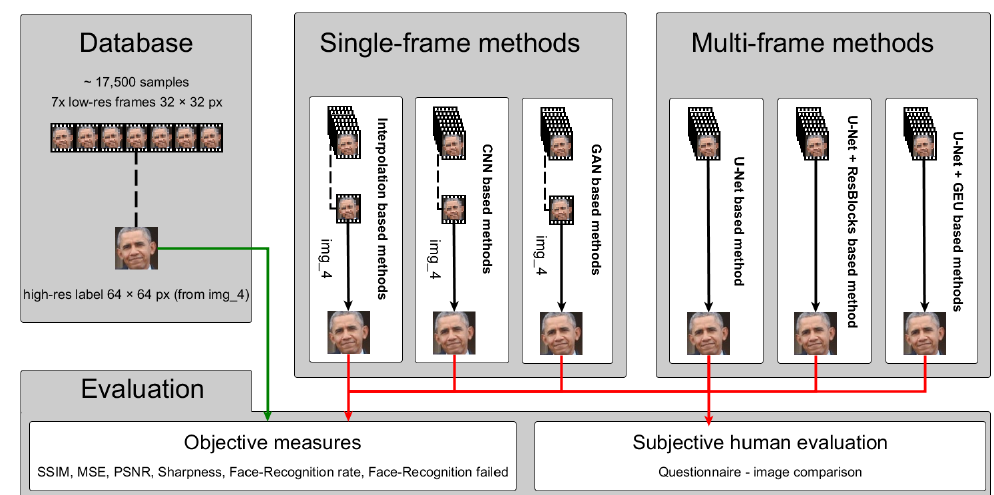
Figure 3. Scheme of the experiment. The dataset consisting of several low-resolution images and one high-resolution target image was used for training and evaluation of a couple of different super-resolution methods. These methods were evaluated using several objective and subjective metrics.